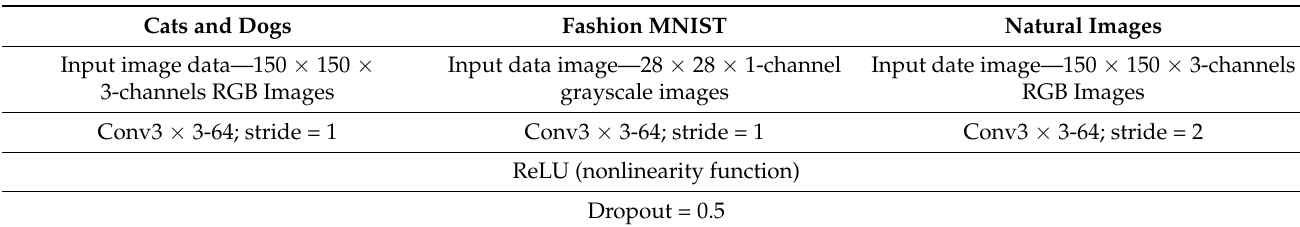
Table 6. Configuration summary of CNN with increasing width denoted as w